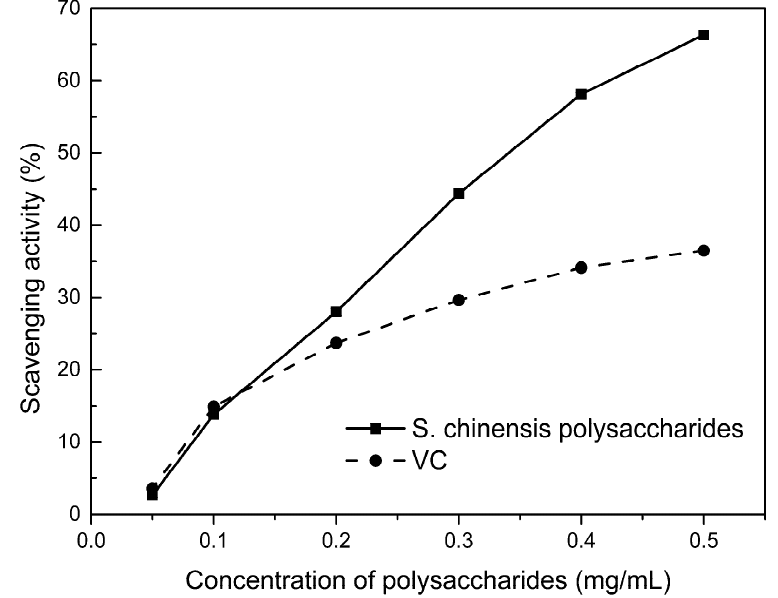
Figure 10. Hydroxyl radical scavenging activity of polysaccharide.